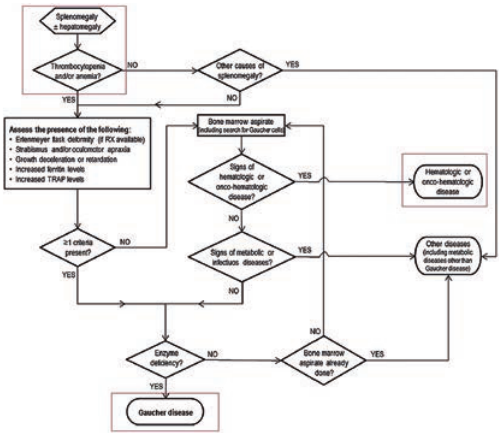
Figura 1. Algoritmo per la diagnosi di Malattia di Gaucher in età pediatrica.